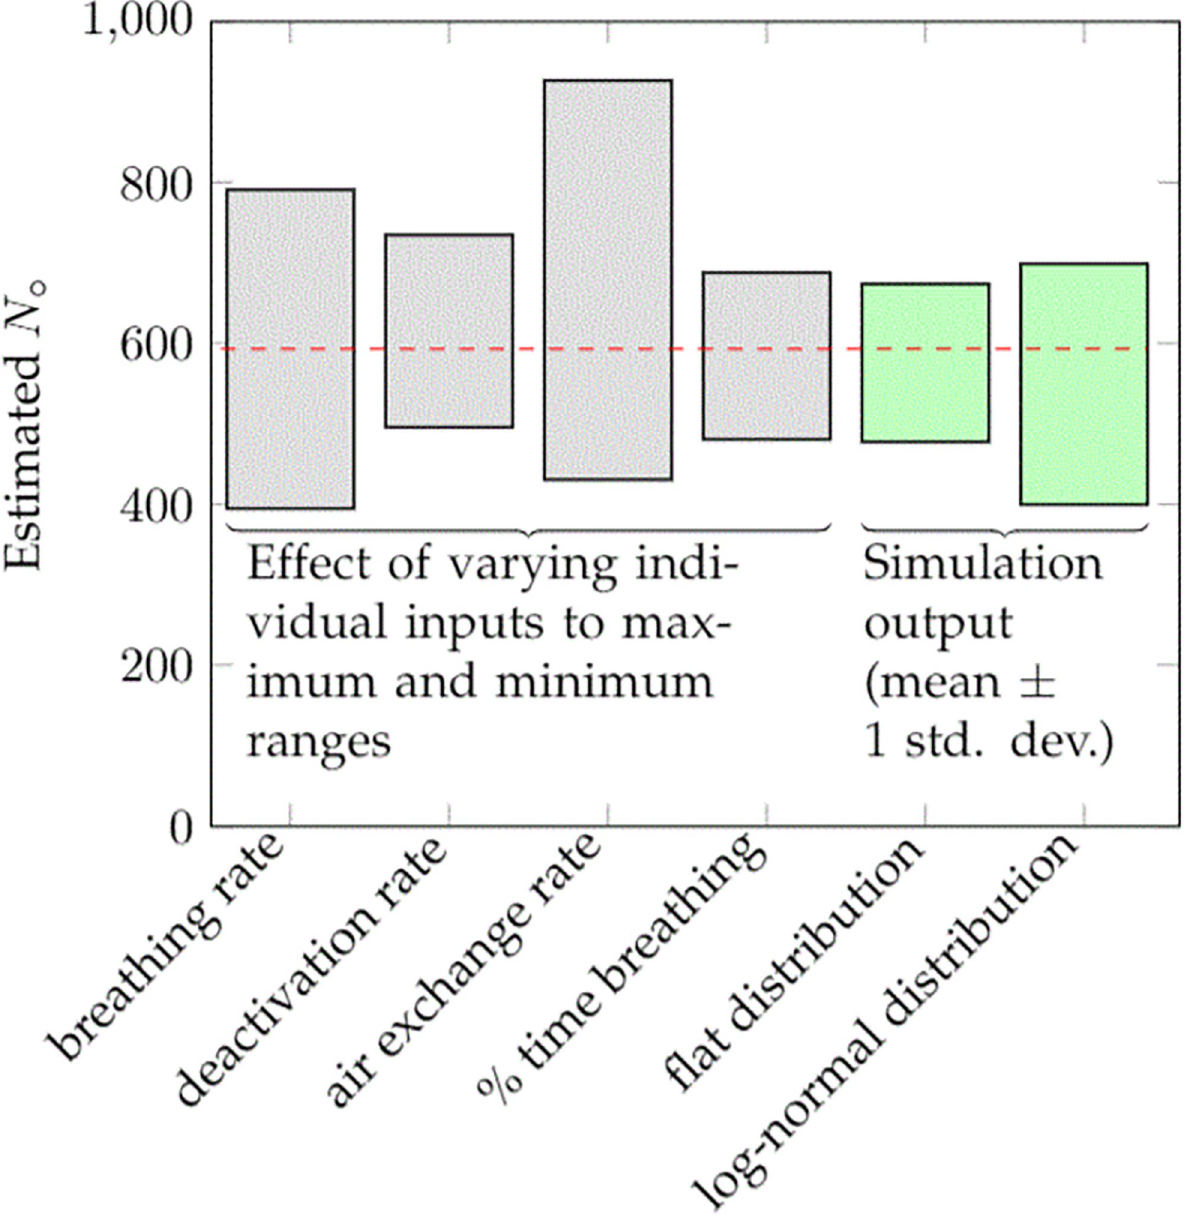
Fig 5. Result of varying individual parameters across entire range (keeping all other parameters constant, left side) and Monte Carlo simulations assuming uniform and lognormal distributions.